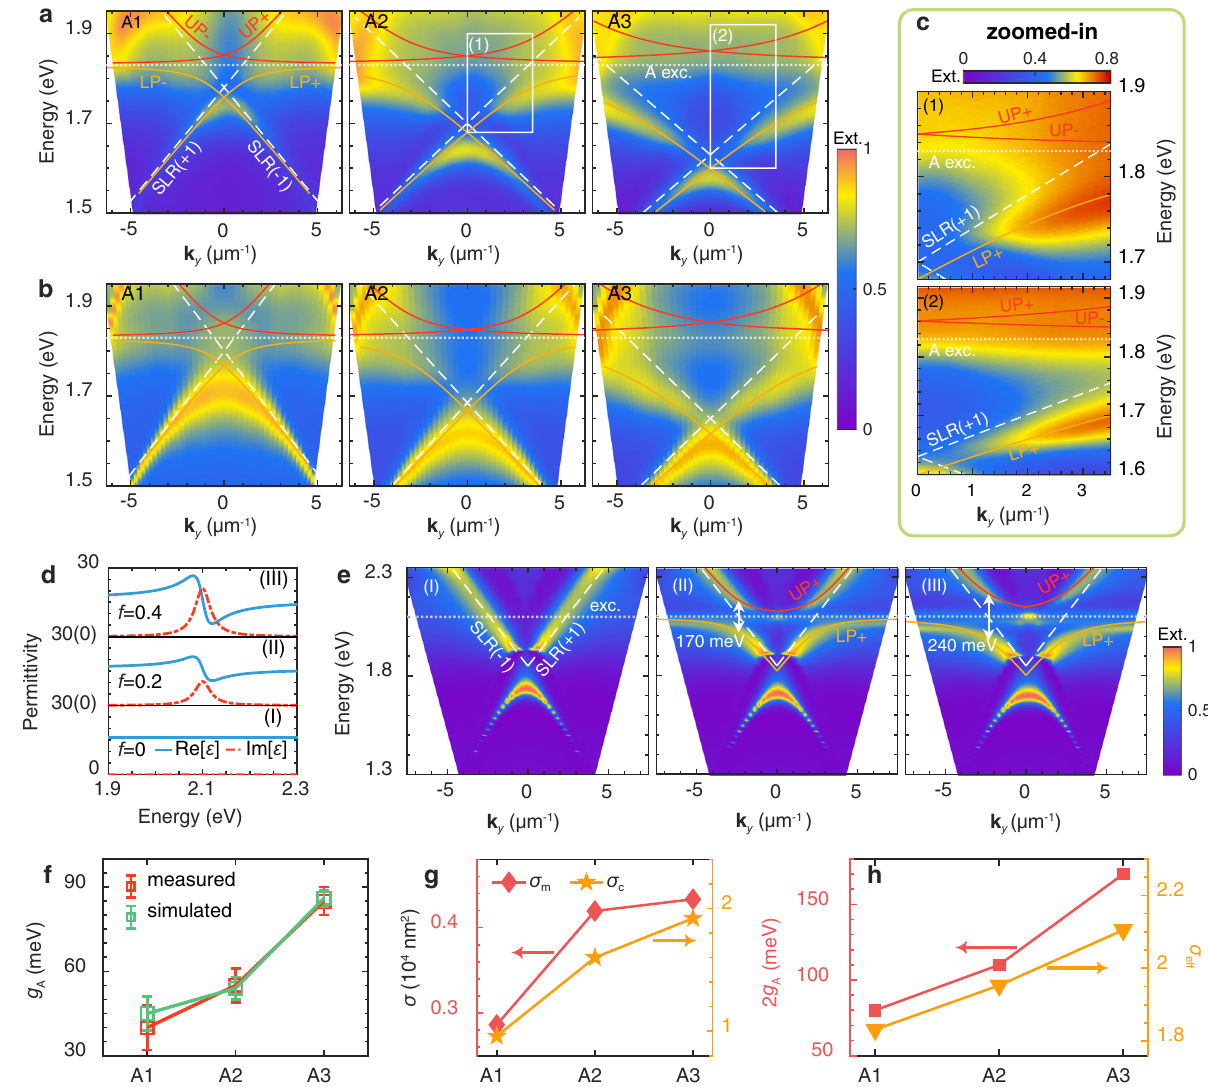
Fig. 4 | Self-coupledpolariton dispersions in 1D MoS 2 gratings. a Measured and ( b ) simulatedangle-resolved extinction spectrafor 1D MoS 2 gratings (A1-A3) along k y ( k x =0). The white dashed lines represent the dispersions of surface lattice resonances (SLRs) of the MoS 2 grating where the symbol ±1 represents the ±1 diffraction orders, i.e., the so-called Rayleigh anomalies (RAs) (see Supplementary Note 2 for more details). The white dotted curves indicate the A excitonic reso- nance. Red and yellow lines represent the dispersions of the upper polariton (UP) and lower polariton (LP) separately, where the +/ (cid:1) symbol represents the